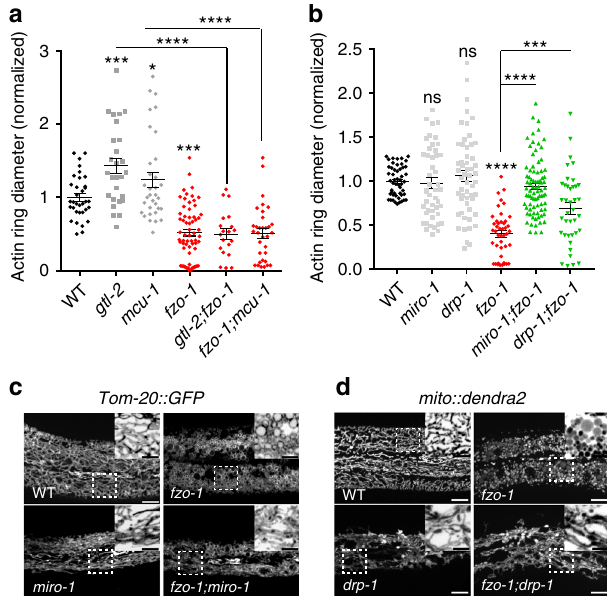
Fig. 5 Mitochondrial fragmentation acts downstream of Ca 2 + -MIRO-1 to accelerate wound closure. a Loss of function in the fusion gene fzo-1 suppresses wound closure defects of gtl-2(n2618) and mcu-1(ju1154) mutants. Quantitation of actin ring diameter in WT and mutants 1 h after needle wounding (WT, n = 50; gtl-2 , n = 27; mcu-1 , n = 33; fzo-1 , n = 64; gtl-2;fzo-1 , n = 20; fzo-1;mcu-1 , n = 33 animals). gtl-2 and mcu-1 mutants display delayed actin ring closure, which is suppressed in double mutants with fzo-1(tm1133) . The WT actin ring diameter was normalized to 1 and mutants normalized to WT. Bars indicate mean ± SEM. * P = 0.0328, *** P = 0.0001, **** P < 0.0001, One-way ANOVA Dunnett ’ s test (single mutant versus WT). two-tailed unpaired t -test (versus mcu-1 or gtl-2 ). b Quantitation of actin ring diameter in the mitochondrial mutants (WT, n = 34; drp-1 , n = 54; miro-1 , n = 47; fzo-1 , n = 44; miro-1;fzo-1 , n = 82; fzo-1; drp-1 RNAi, n = 39 animals). drp-1 partially suppresses fzo-1 while miro-1 signi fi cantly suppresses the fzo-1 in enhanced wound closure. Bars indicate mean ± SEM. ns, P = 0.7753 ( drp-1 ) or 0.9893 ( miro-1 ), *** P = 0.0002, **** P < 0.0001, two-tailed unpaired t -test (versus fzo-1 ). One-way ANOVA Dunnett ’ s test (single mutant versus WT). Source data are provided as a Source Data fi le. c Representative confocal images of mitochondrial morphology in fzo-1 and miro-1 ; fzo-1 mutants. Pcol-19-Tomm-20::GFP (zjuSi48) transgenic animals label the mitochondria. fzo-1 mutants display fragmented and round shaped mitochondria. miro-1;fzo-1 double mutants have tubular mitochondria, similar to miro-1 single mutants. N = 3 independent experiments. d Representative confocal images of mitochondrial morphology in fzo-1 and drp ; fzo-1 mutants. Mitochondria were labeled with mito::dendra2(juSi271) , the mitochondrial morphology of drp-1;fzo-1 mimics drp-1 , without fragmented mitochondria. Note, drp-1 suppress fzo-1 in mitochondrial morphology. Scale ( c , d ), 10 μ m and 5 μ m (zoom-in